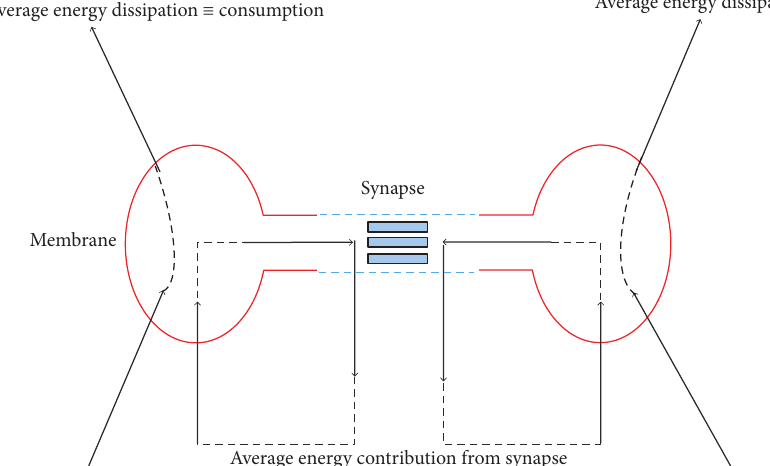
Figure 20: Global energy flow of neurons and